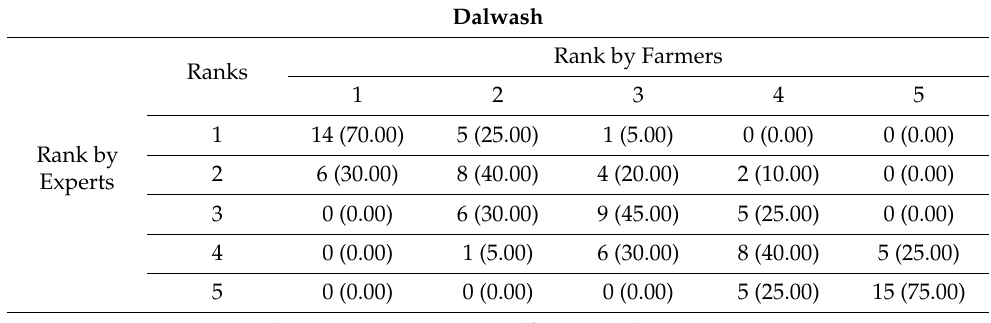
Table 5. Comparison of farmers’ assessment of soils vis- à -vis scientific assessment.